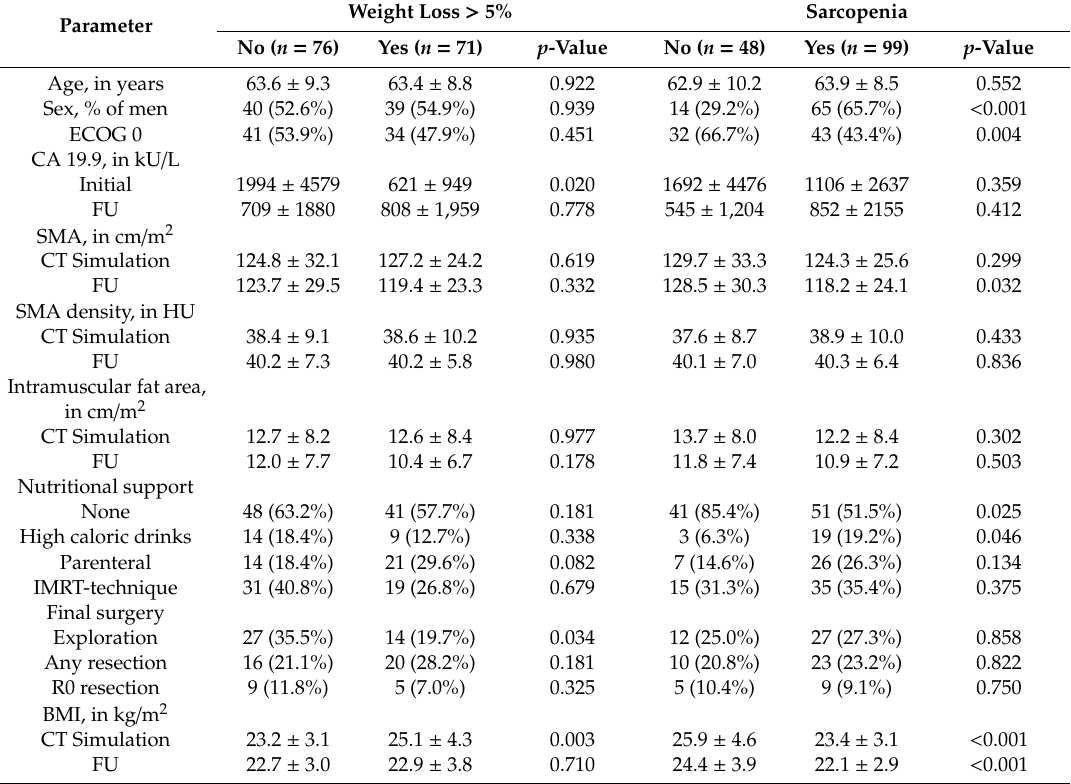
Table 2. Clinical parameters grouped according to cachectic weight loss and sarcopenia.